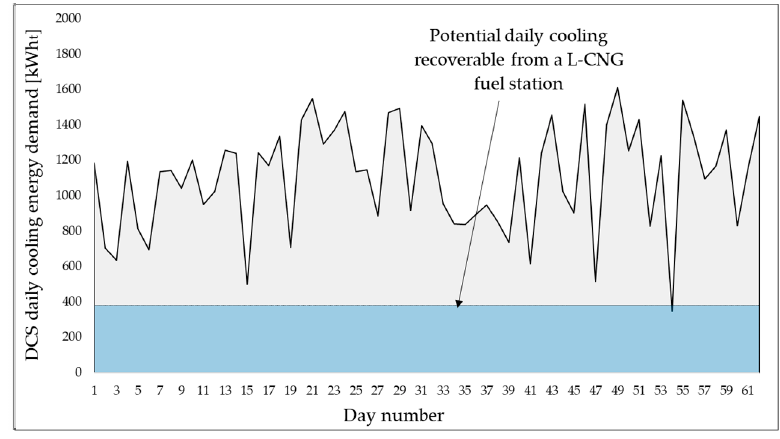
Figure 3. District daily cooling energy demand (July and August).